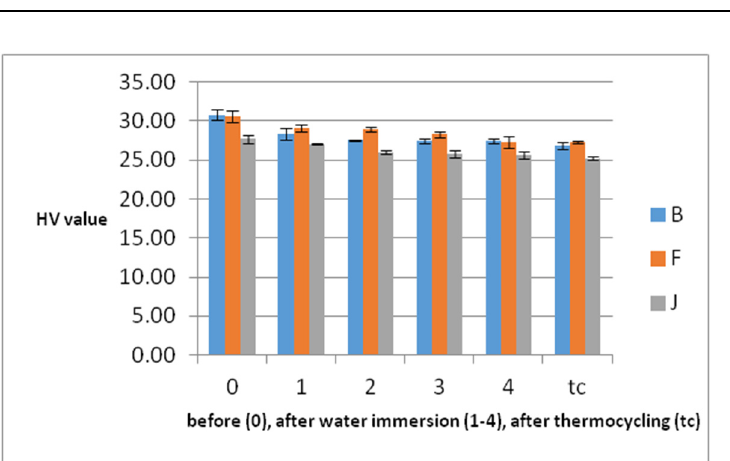
Figure 5. Nanoroughness values of the samples before each week of water immersion(0), after